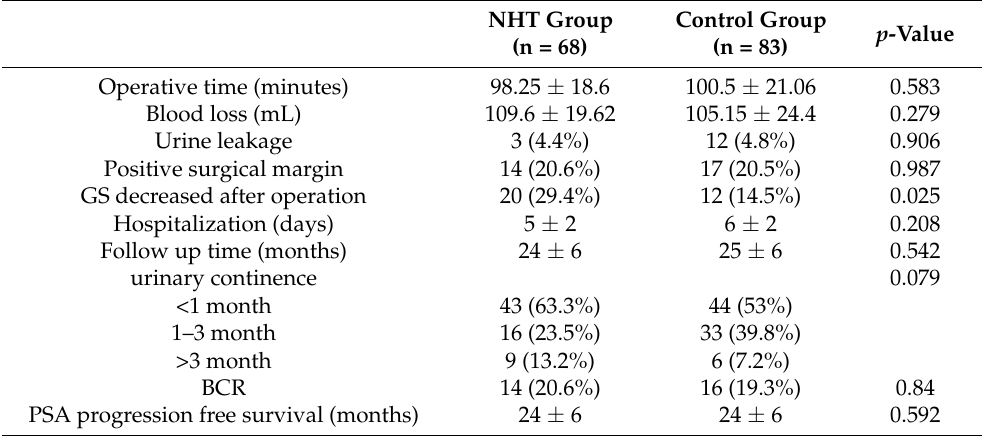
Table 4. Comparison of postoperative clinical characteristics between the NHT and control groups in RALP cohort.